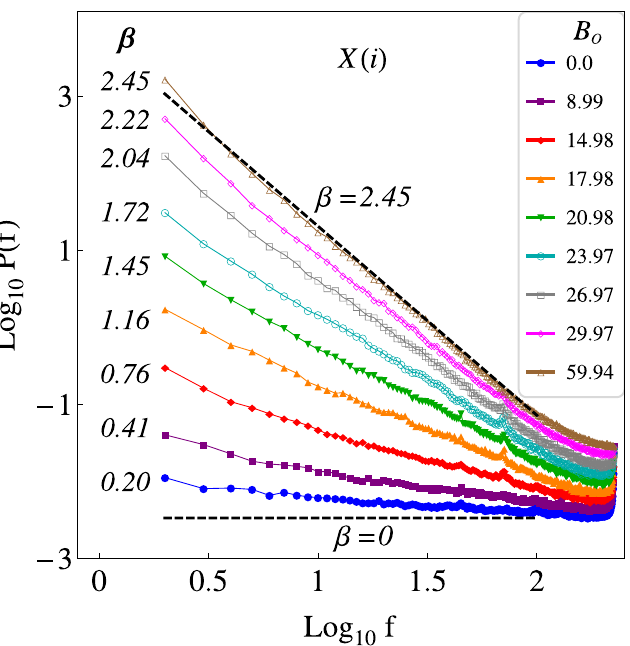
Figure 2. Fourier power spectra of the time series of the particle positions, in the x -direction X ( i ), for different values of B o , and φ s = 0.17 . The correlation strength β is calculated from the slope of a straight line adjusted to each power spectrum in log–log scale. In both cases we can observe that the values of β increase, from β ≈ 0 to β ≈ 2.5 , as B o assumes higher values. The results correspond to power spectra averaged over all the